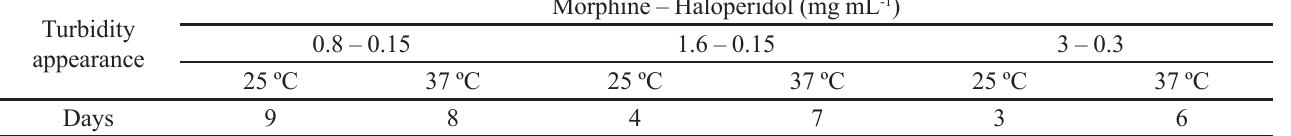
TABLE I - Physical stability study